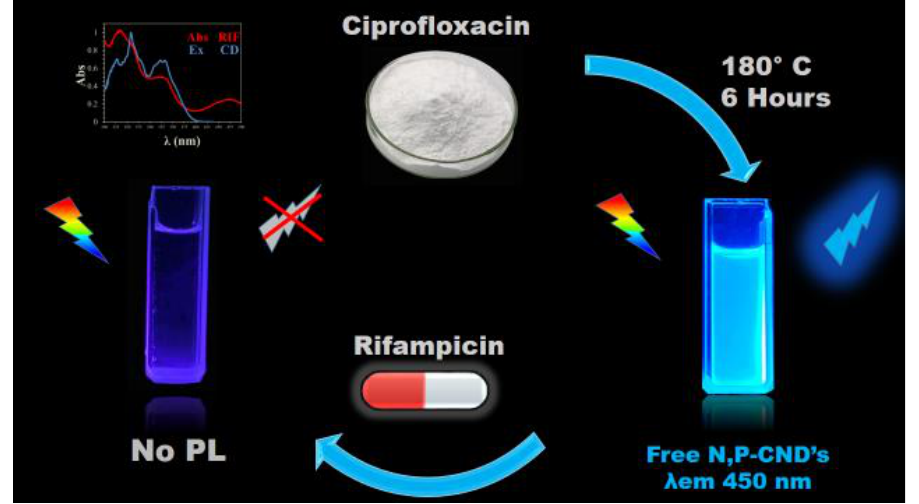
Figure 1. Schematic illustration of the hydrothermal preparation of the carbon nanodots (CNDs) and quenching using rifampicin due to the overlap of the rifampicin absorption spectra with the CNDs excitation spectra. PL: